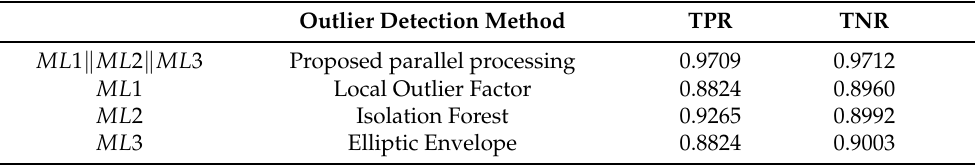
Table 6. Resulting performance of the parallel anomaly detection